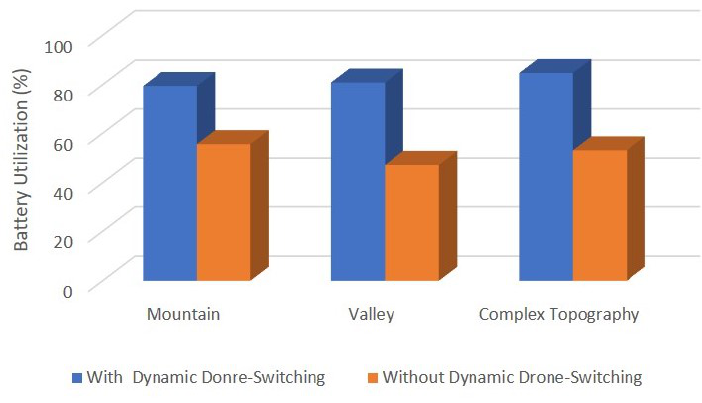
Figure 9. The location dynamic switching algorithm